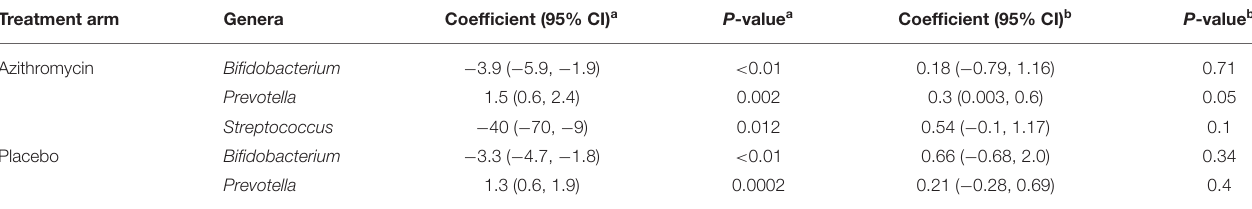
TABLE 5 | Longitudinal comparison of relative abundance of individual genera after 4 rounds of biannual treatment compared to baseline in the azithromycin and placebo arms within the BL vs. 4MDA dataset. Treatment arm Genera Coefficient (95% CI) a P -value a Coefficient (95% CI) b P -value b